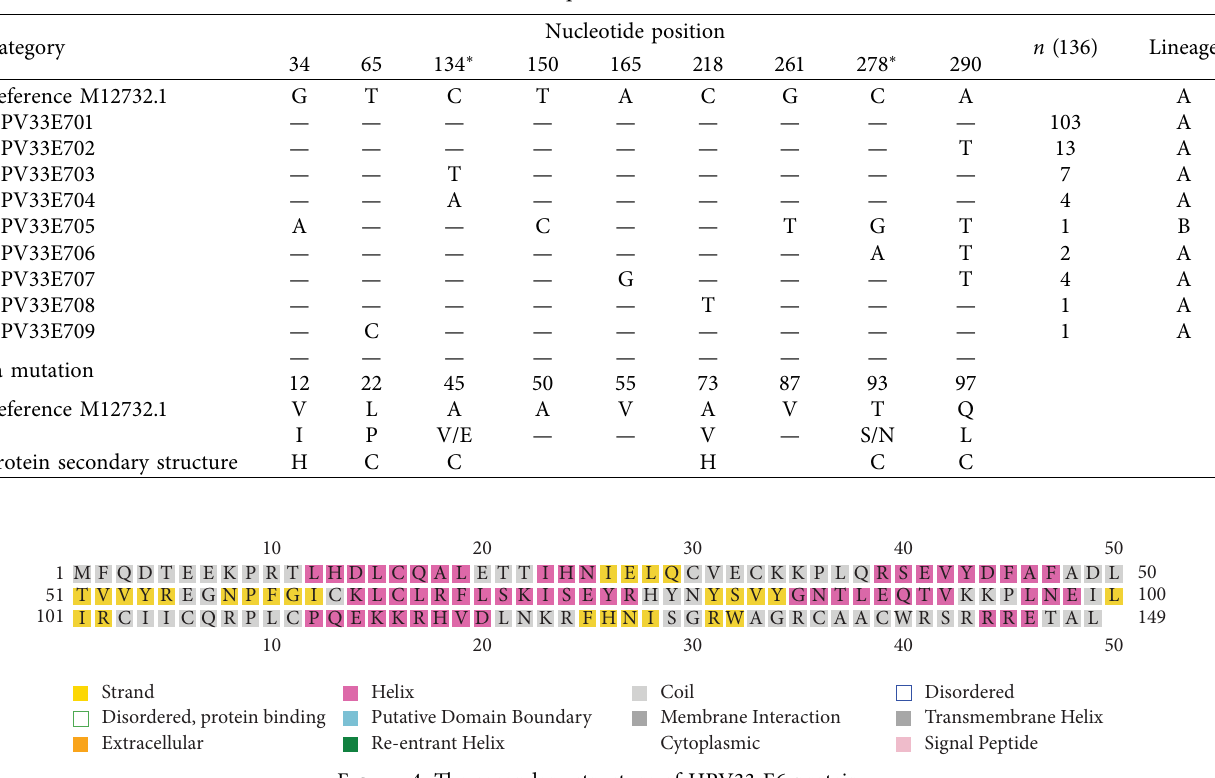
Table 5: Nucleotide sequence mutations of HPV33E7.